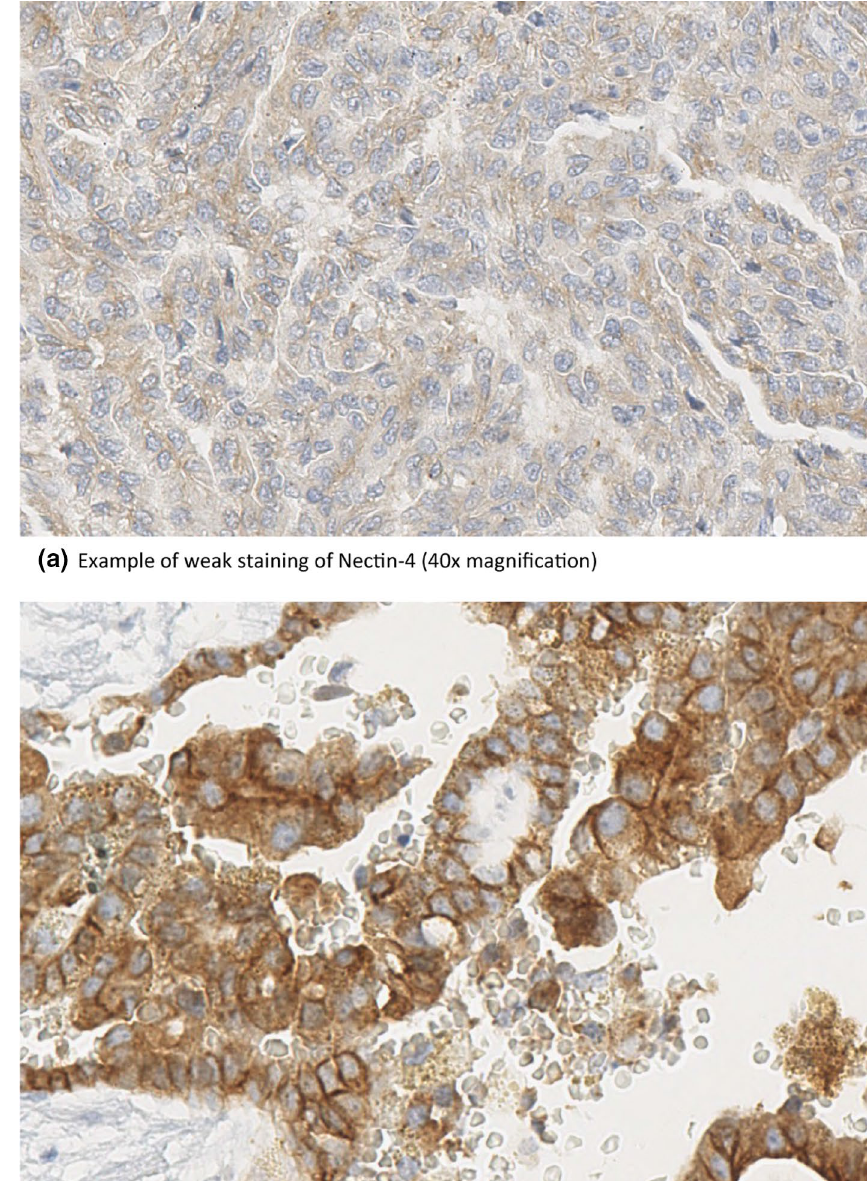
Fig. 2 Immunohistochemical staining of Nectin-4 a Example of weak staining of Nectin-4 (40×magnification) b Example of strong staining of Nectin